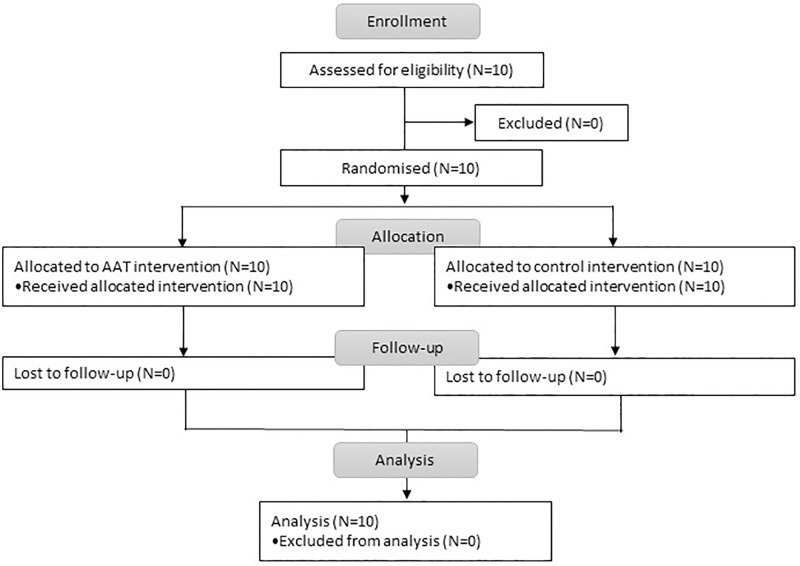
CONSORT flowchart.